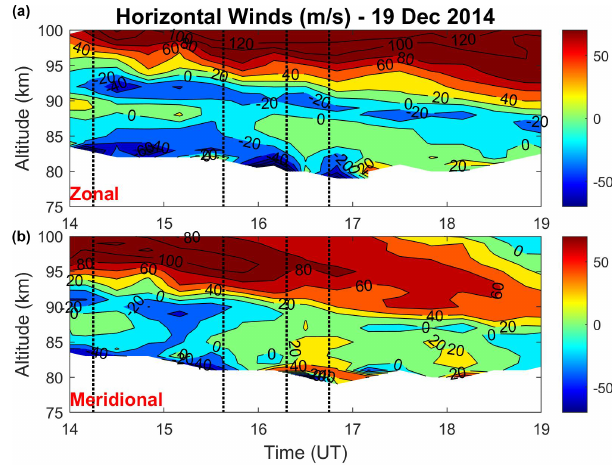
Figure 8. Measured winds: (a) zonal and (b) meridional. The dotted black lines show the estimated times of zenith passage of the fronts.